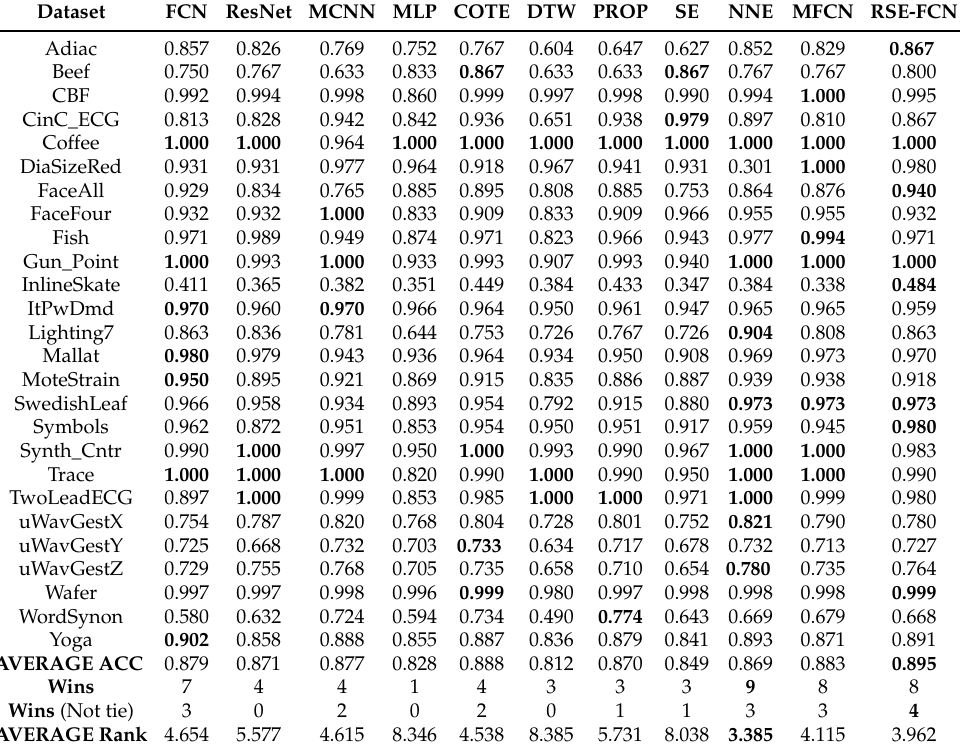
Table 2. Comparison between RSE-FCN and all